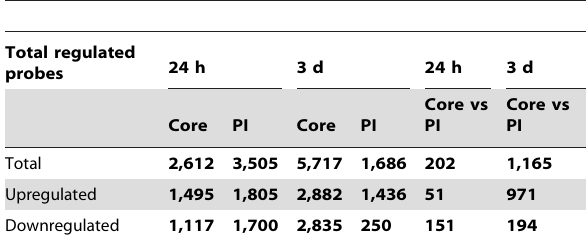
Table 1. Number of genes differentially regulated at 24 hours and 3 days after